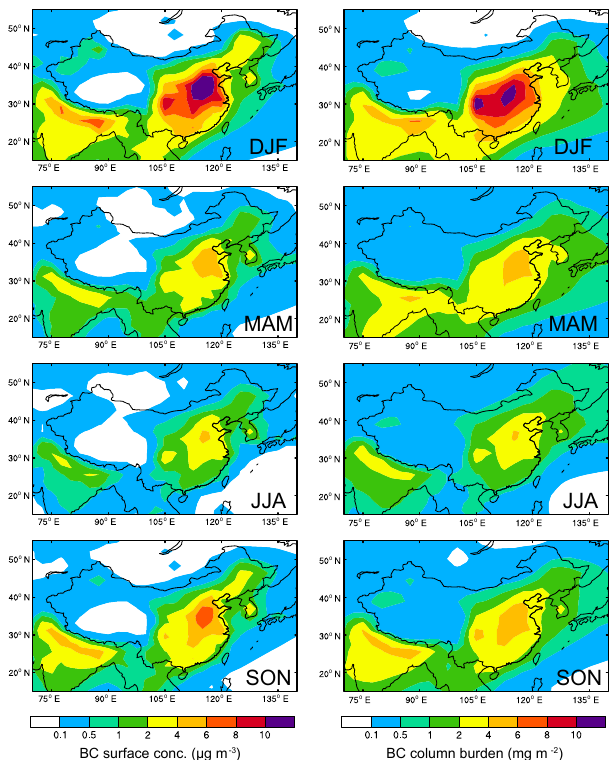
Figure 2. Simulated seasonal mean near-surface concentrations (left; units: µgm − 3 ) and column burden (right; units: mgm − 2 )